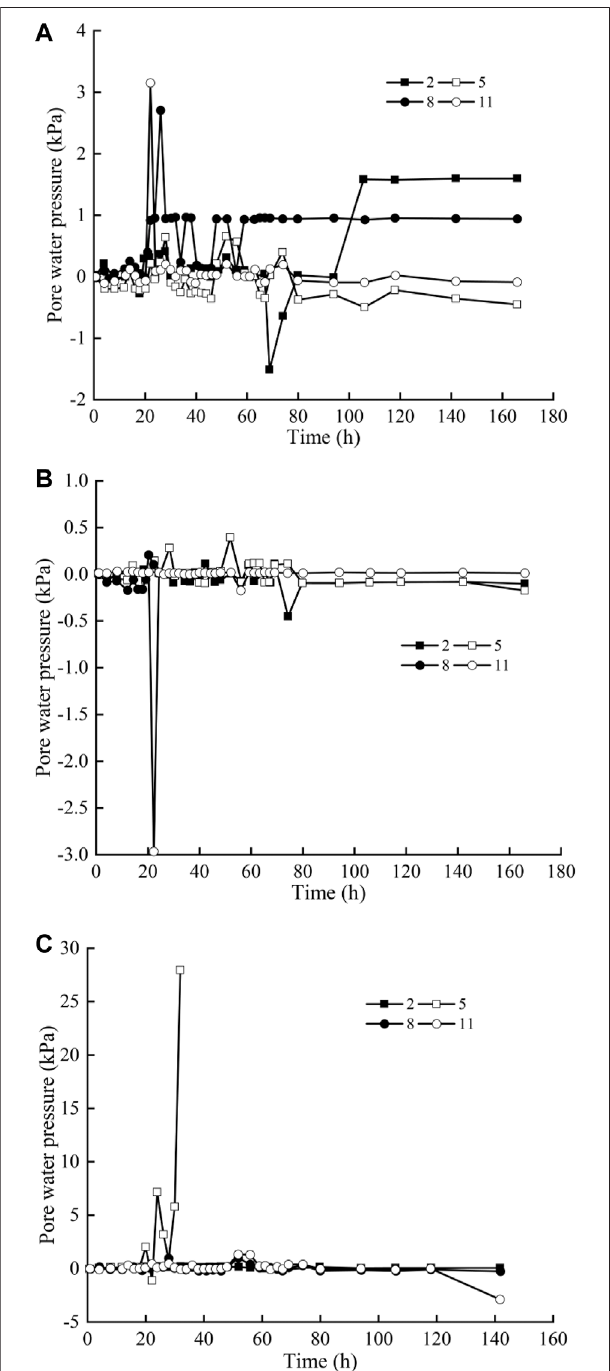
FIGURE 3 | Pore pressure with construction time perpendicular to tunnel direction at different burial depths: (A) 10 m, (B) 13 m, and (C) 16 m. layer below 14 m away from the ground surface, the stress redistributes due to the soil disturbance of the tunnel shield excavation. Therefore, the earth pressure of the soil below 14 m from the ground surface decreases.